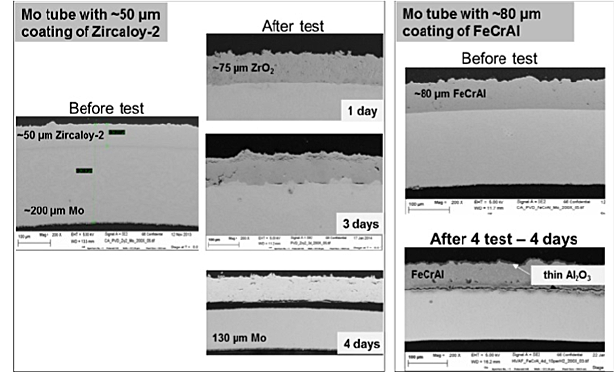
Fig. 9. Open-ended Mo-alloy tube samples with coating after oxidation test in 1000 ° C for up to 4